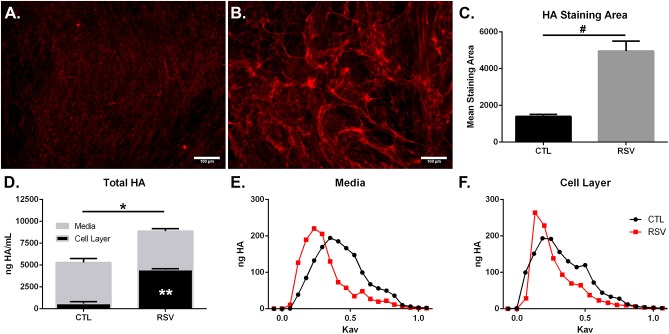
Imaging studies were performed to label HA deposition (red) by HLFs in (A) control HLFs and (B) RSV-infected HLFs. (C) Quantitative analysis of staining area demonstrated a 3.5-fold increase in the staining of HA (#P < 0.03). (D) Quantitative analysis of HA accumulation revealed that HLFs infected with RSV displayed increased total HA accumulation (8,878 ± 114.4 ng/mL vs. 5,295 ± 389.6 ng/mL, *P < 0.0009). Differences were driven by increased HA contained in the HLF cell layer following RSV infection (4,477 ± 56.13 ng/mL vs. 600.8 ± 128.3 ng/mL, **P < 0.0001) without significant differences in the media compartment HA content. Data shown as mean ± SD for N = 3 replicates/group. HLFs infected with RSV demonstrated a greater abundance of HMW-HA species compared to HLF controls in both (E) media and (F) cell layer compartments. A representative plot of HA profiles measured by S-1000 size exclusion chromatography is shown. Data is plotted as ng HA vs. the partition coefficient (Kav) for N = 3 replicates/group.